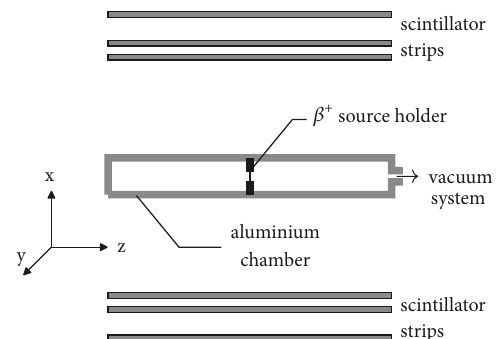
Figure 3: Scheme of the positronium production setup devised for positron polarization determination in J-PETexperiment.Positrons are produced in a 𝛽 + source mounted in the center of a cylindrical vacuum chamber coaxial with the detector. Positronium atoms are formed by the interactionof positrons in a porous medium covering the chamber walls. Determination of an o-Ps 󳨀→ 3 𝛾 annihilation positioninthecylinderprovidesanestimateofpositronmomentum direction.